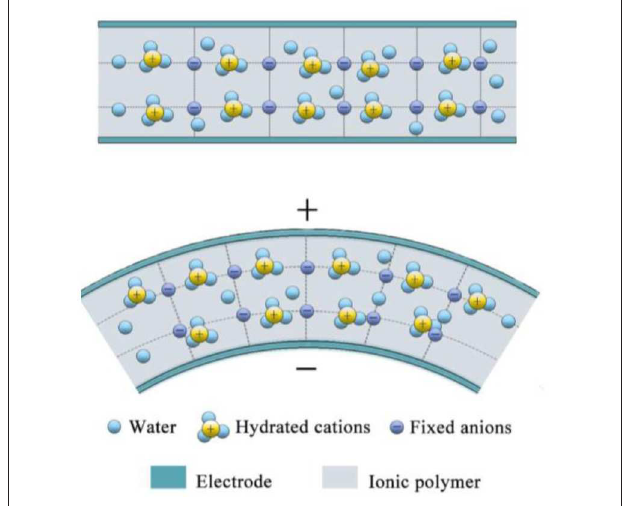
FIGURE 2 | Ionic polymer–metal composite (IPMC) sensing under bending deformation (Wang et al., 2019) (reprinted with